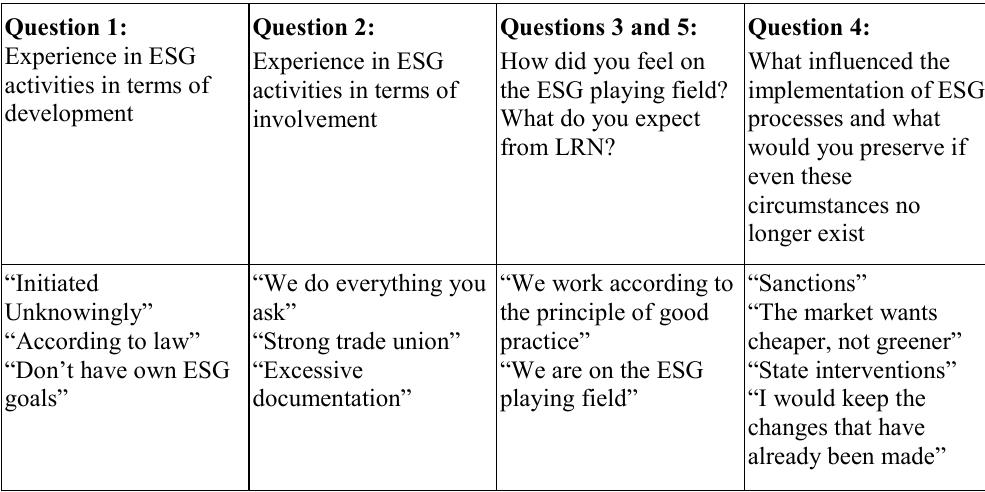
Table 1. Frequently Used Phrases within the Focus